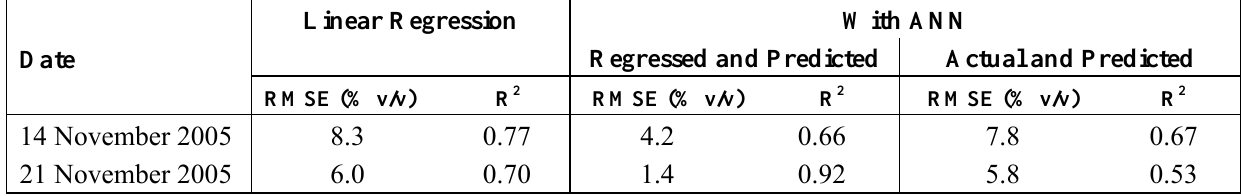
Table 9. RMSE and R 2 between the regressed and actual soil moisture